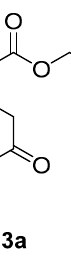
Figure 1. Structure of the hydration derivative 3a.